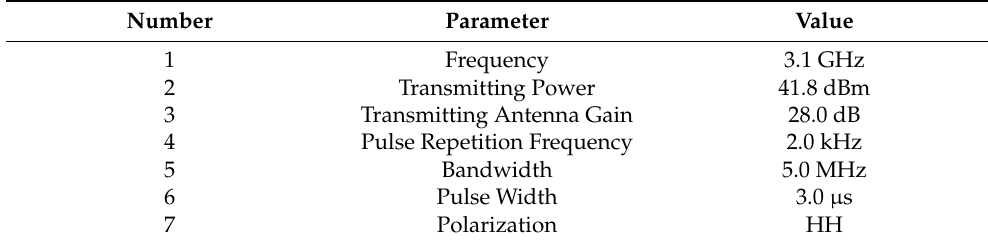
Table 1. S − band radar system parameters in the over − the − horizon propagation experiment.